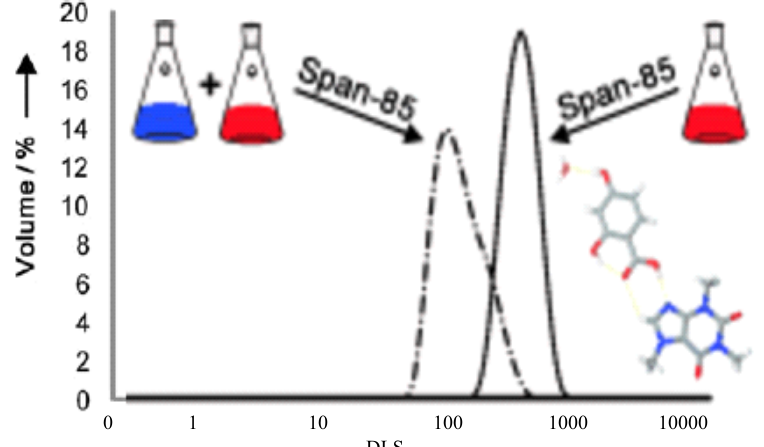
[39].DLS Fig. 4. Particle size distribution for (caff)•(dhba)•(H2O) from single solvent and two solven- tapproaches with Span-85. Adapted from Ref Fig. 4. Particle size distribution for (caff)·(dhba)·(H 2 O) from single solvent and two-solvent approaches with Span-85. Adapted from Ref [38].